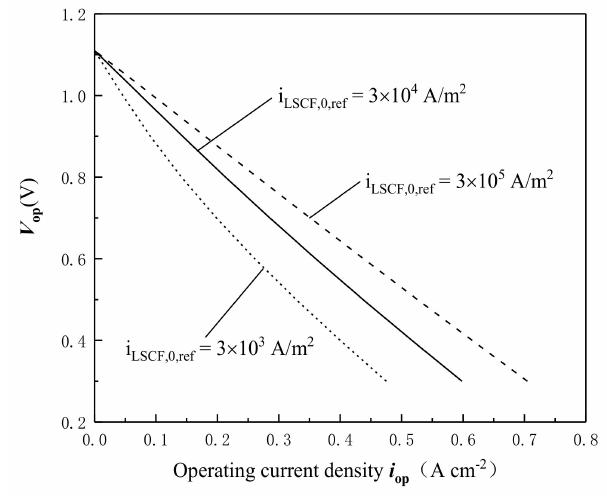
Figure 7. Dependence of the PCFC performance on the reference exchange current density i LSCF,0,ref at T = 550 ◦ C.